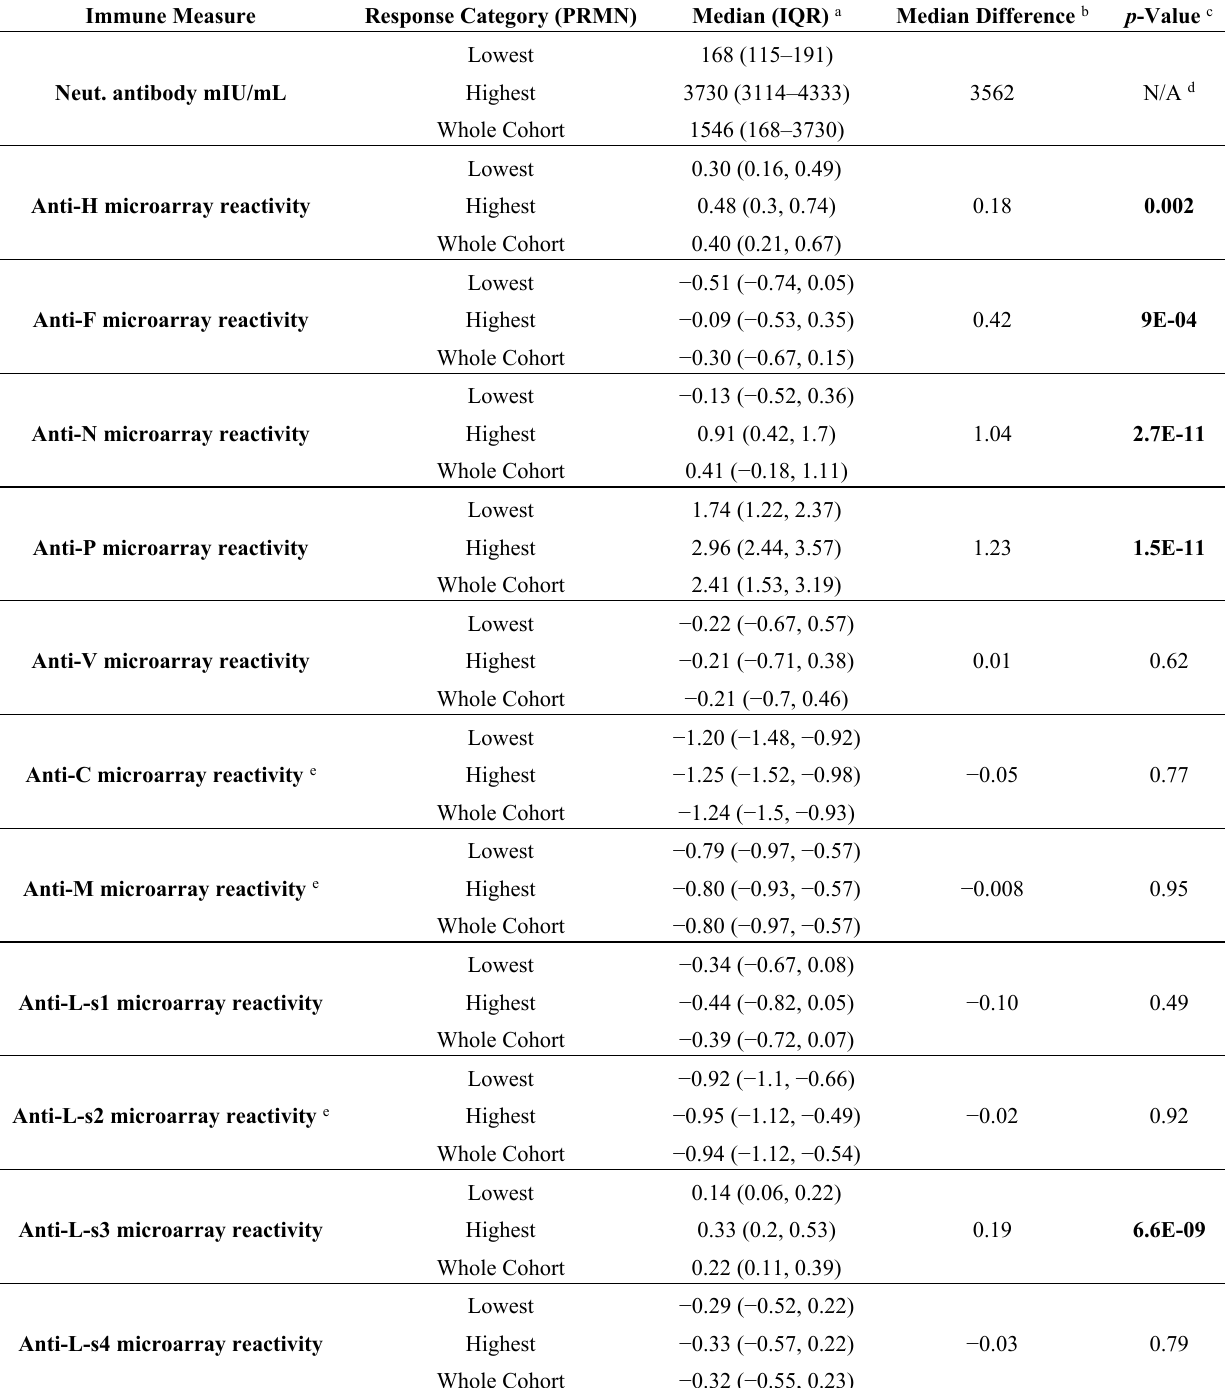
Table 2. Proteome array characterization of the measles-specific humoral immune response in the study